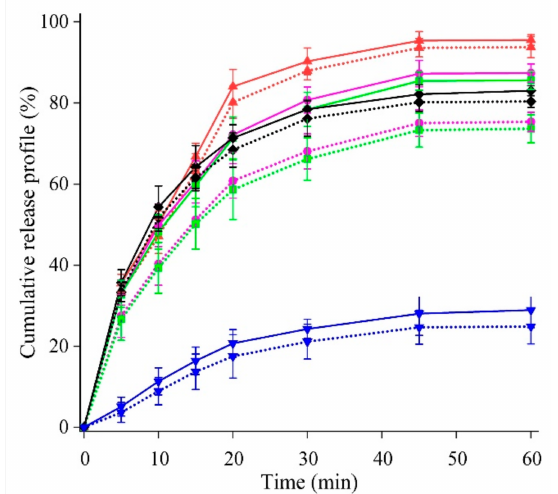
Figure 7. Cumulative release profile of the compressed tablets, formed from GLN reference at 0-day (in solid blue) and at 30-day (in dotted blue), GLN-dioxanate at 0 day (in solid red) and at 30-day (in dotted red), GLN-NMPate at 0 day (in solid pink) and at 30-day (dotted pink), GLN-DMSOte at 0 day (in solid green) and at 30-day (in dotted green), GLN-THPate at 0 day (in solid black) and at 30-day (in dotted